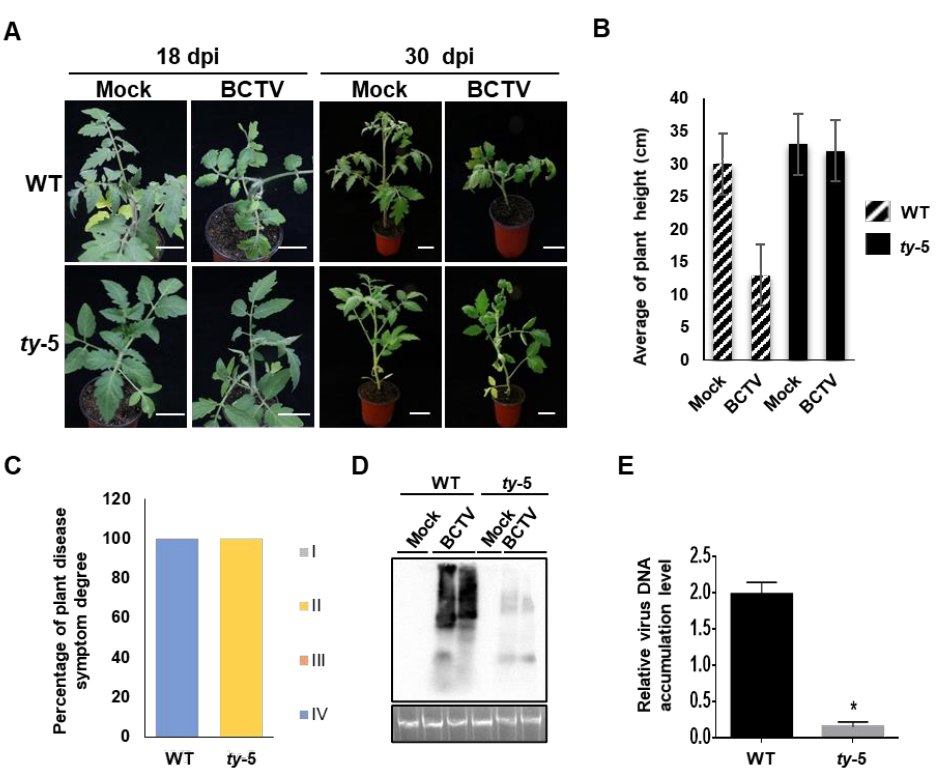
Figure 3. ty -5 confers resistance to beet curly top virus (BCTV), a geminivirus in the genus Curtovirus. ( A ) Viral symptoms of the tomato ty-5 line and the wild-type (WT) line agroinfected with either the pBinPLUS empty vector (mock) or an infectious clone of BCTV. Systemically infected leaves and entire plants were photographed at 18 and 30 days post-inoculation (dpi), respectively. ( B ) The mean height of WT and ty-5 plants infected with BCTV at 30 dpi. ( C ) The percentage and degree of disease symptoms in WT and ty-5 plants infected with BCTV at 30 dpi. Fifteen plants from each of the WT and ty-5 lines were used for the assays. Disease symptoms were classified from grade I (no symptoms) to grade IV (very severe symptoms). ( D ) Southern blotting analysis of viral DNA accumulation in WT and ty-5 lines infected with BCTV at 30 dpi. A DNA fragment of BCTV capsid protein was used as a probe for detection of genomic DNA from BCTV. ( E ) qPCR analysis of viral DNA accumulation in WT and ty-5 lines infected with BCTV at 30 dpi. Specific primers for BCTV capsid protein were used to quantify the accumulation of viral DNA; 25S rRNA was used as the internal control. Asterisks denote statistically significant differences evaluated with Student’s t test, * p < 0.05.